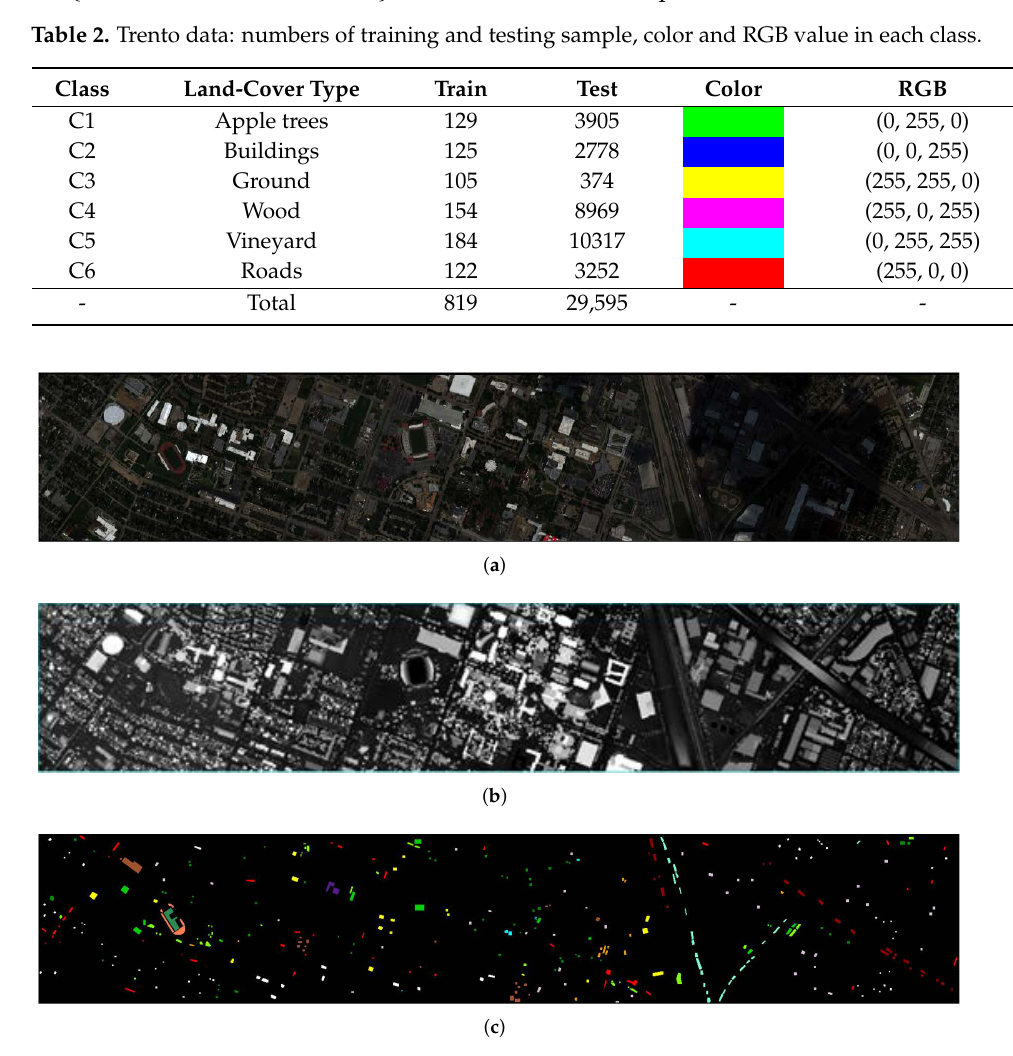
Figure 4. Visualization of the 2012 Houston Data. ( a ) False-color images of hyperspectral data using 64, 43, and 22 as R, G, B, respectively. ( b ) Gray images of LiDAR data. ( c ) Ground-truth